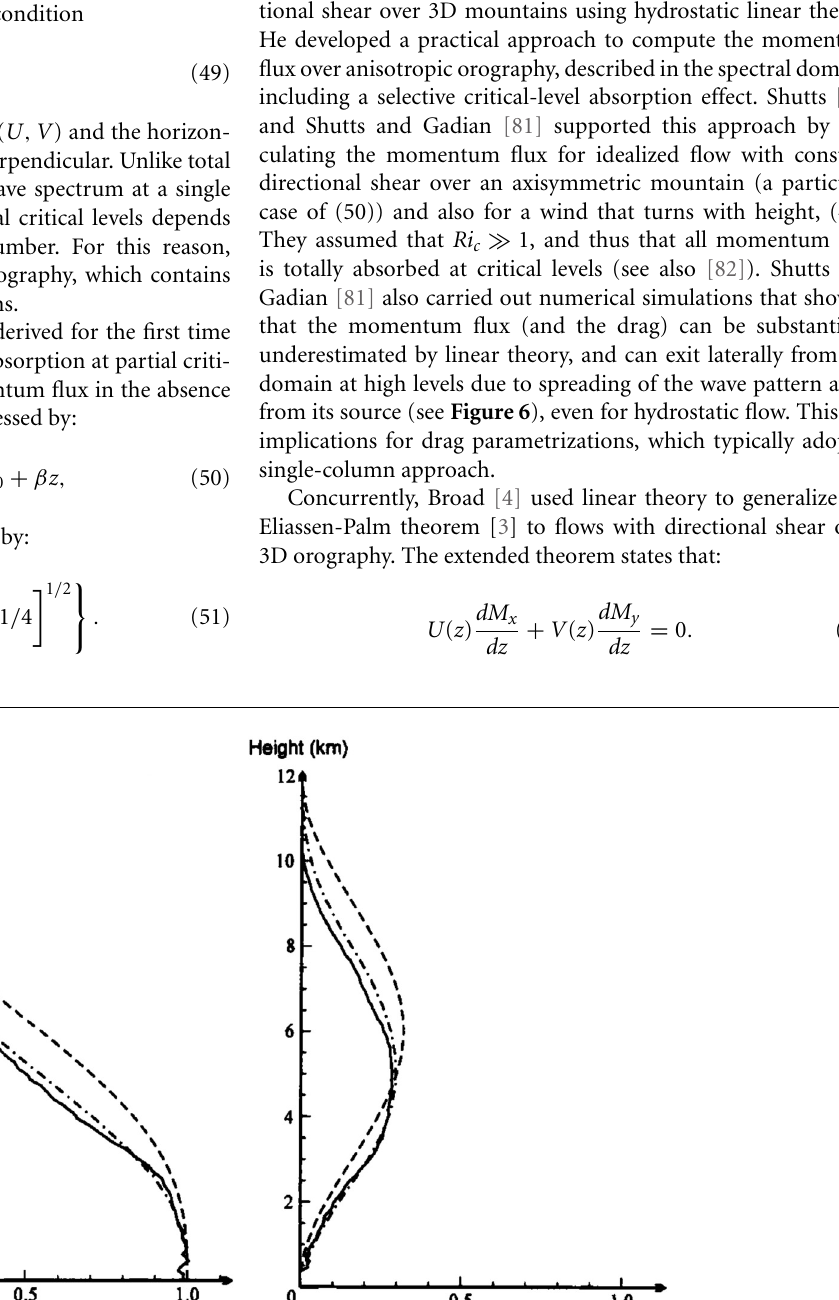
domain extent, solid line: numerical simulations. Reproduced from Figure 12 of Shutts and Gadian [81]. Copyright © 1999 Royal Meteorological